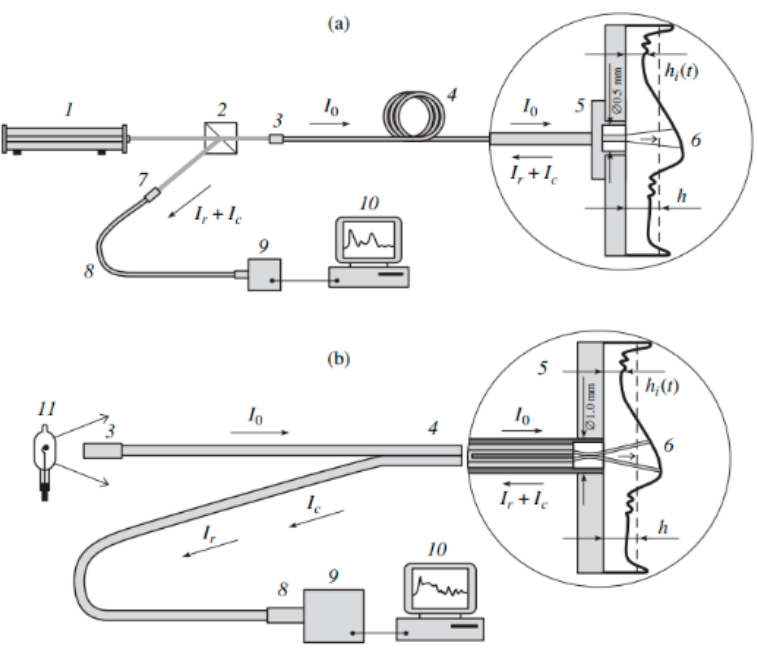
Figure 2. Block diagram ( a ) of a single-fiber circuit; ( b ) a modified two-fiber diagram (1) of a He-NE laser, (2) of a Wollaston prism, (3,7) of volumetric lenses, (4) of an optical fiber, (5) of a sleeve, (6) a plate, (8) a receiving optical fiber, (9) a photodetector unit (10) a personal computer, and (11) a halogen incandescent lamp.